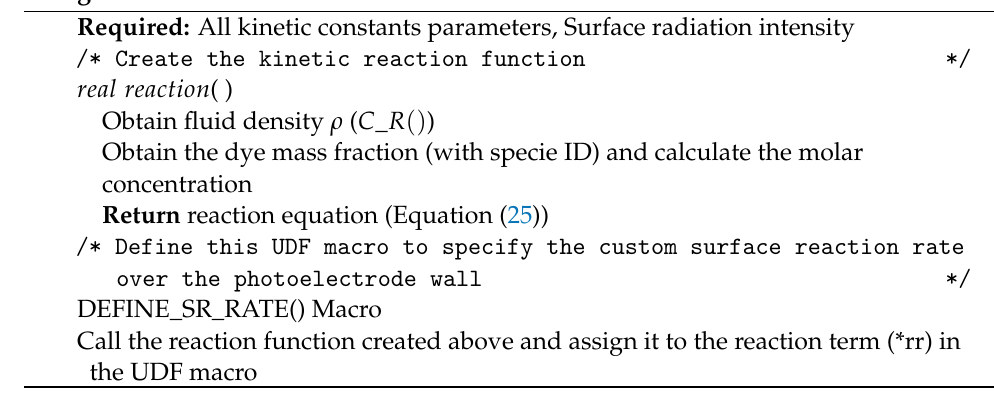
Algorithm A3: Mass transfer coefficient